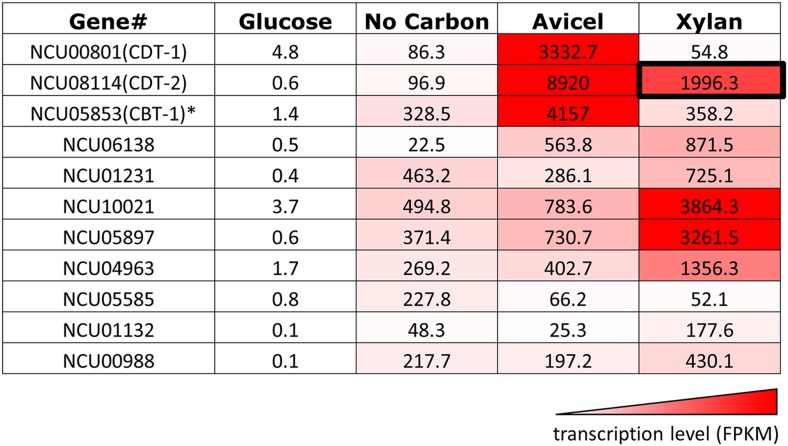
Transcriptional levels of transporters expressed in N. crassa grown on different carbon sources.Transcript levels reported in fragments per kilobase per million reads (FPKM) are derived from experiments published in Coradetti et al. (2012); Sun et al. (2012). *CBT-1 transports cellobionic acid, the product of lytic polysaccharide monooxygenases (LPMOs, or CaZy family AA9 and AA10) (Xiong et al., 2014).